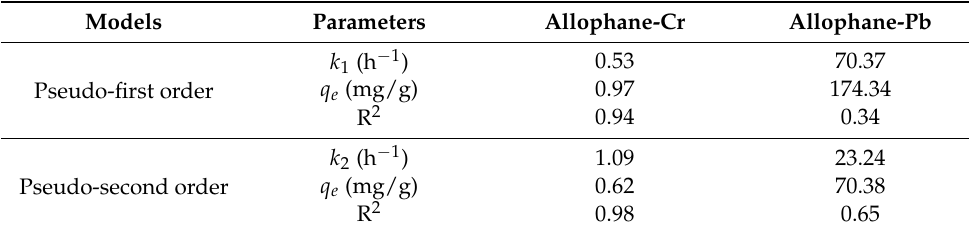
Figure 7. Kinetics of ( a ) CrO 42 − and ( b ) Pb 2+ adsorption onto synthetic allophane. The dosage of the absorbent was 40 mg/L. Table 2. Kinetic parameters of CrO 42 − and Pb 2+ onto synthetic allophane derived from pseudo-first order model and pseudo-second order model.